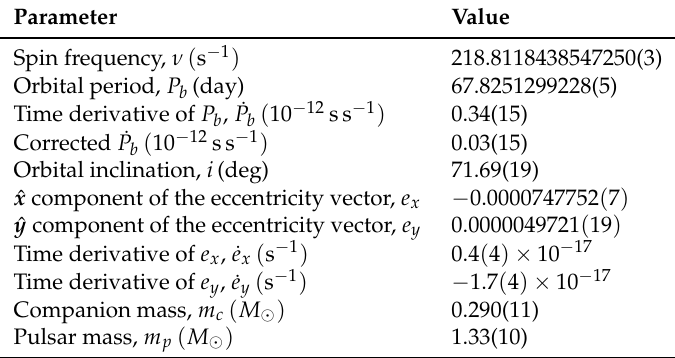
Table 1. Parameters for PSR J1713+0747 [9]. The numbers in parentheses indicate the uncertainties on the last